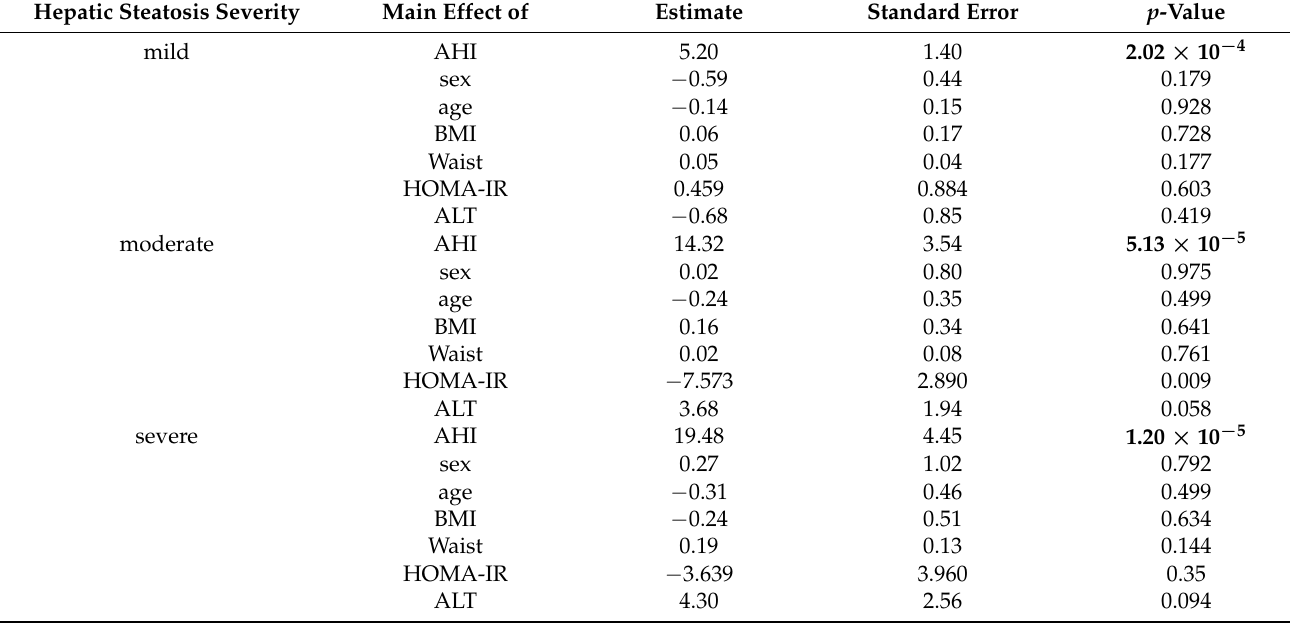
Table 2. Results of multinomial logistic regression examining the relationship between AHI and severity of hepatic steatosis. Significant p -values after Bonferroni correction are highlighted in